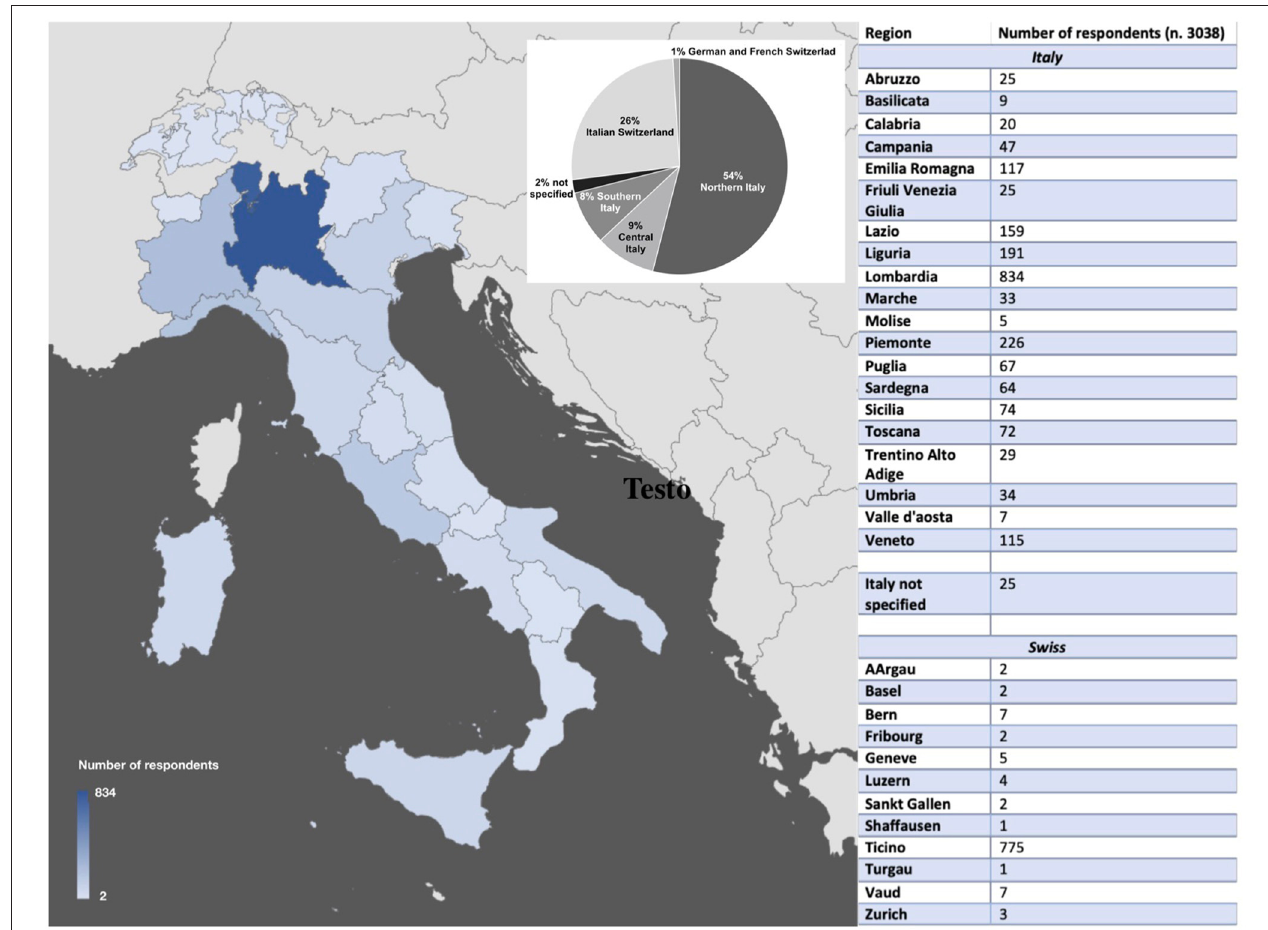
FIGURE 1 | Participants’